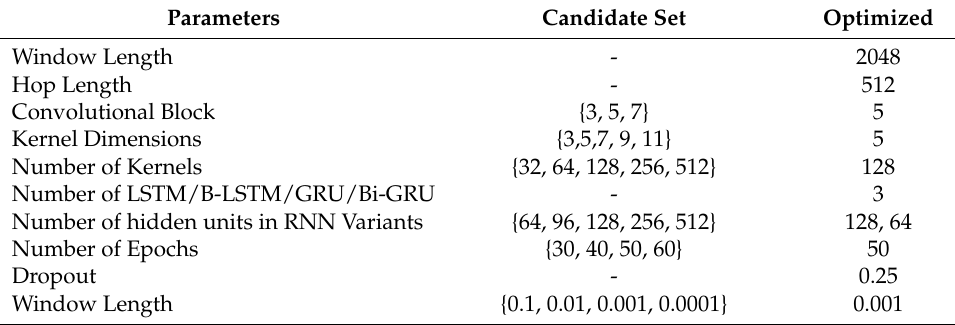
Table 1. Parameter configuration used to build the proposed architecture.